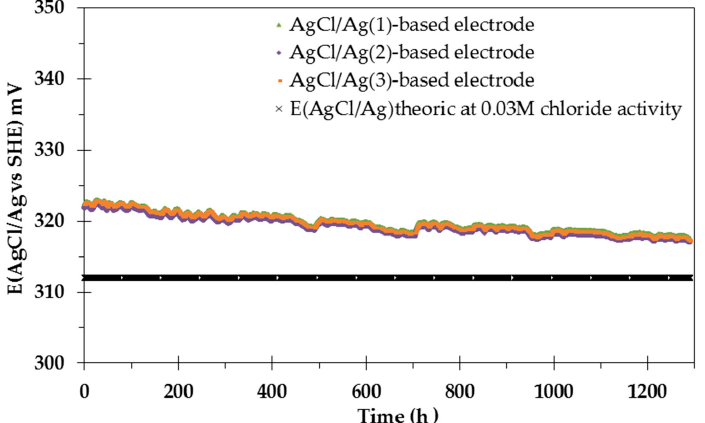
Figure 10. Evolution of the potentiometric response of the all-solid-state AgCl/Ag-based electrodes at constant pH (7.4) as a function of time over 54 days. Measurements were made in the reconstituted COx solution, at 25 °C in the glove box.